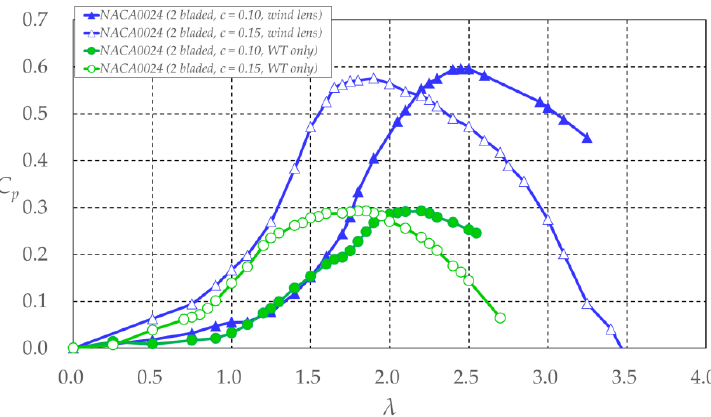
Figure 15. Comparison of power coefficient C p of wind turbines with different chord lengths with and without a wind lens vs. tip speed ratio λ (wind lens: L = 1.14 D m, h = 0.5 D m, φ = 15°). Refer to Figure 2 for L , D , h , and φ.